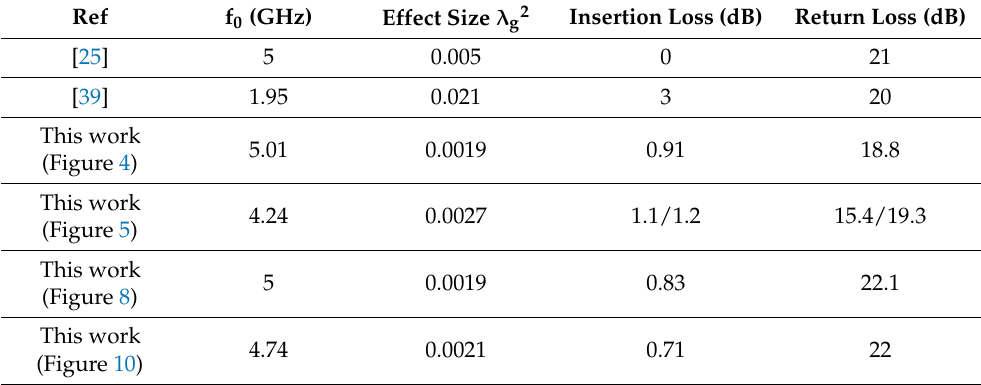
Table 2. Comparison between different models of resonators.